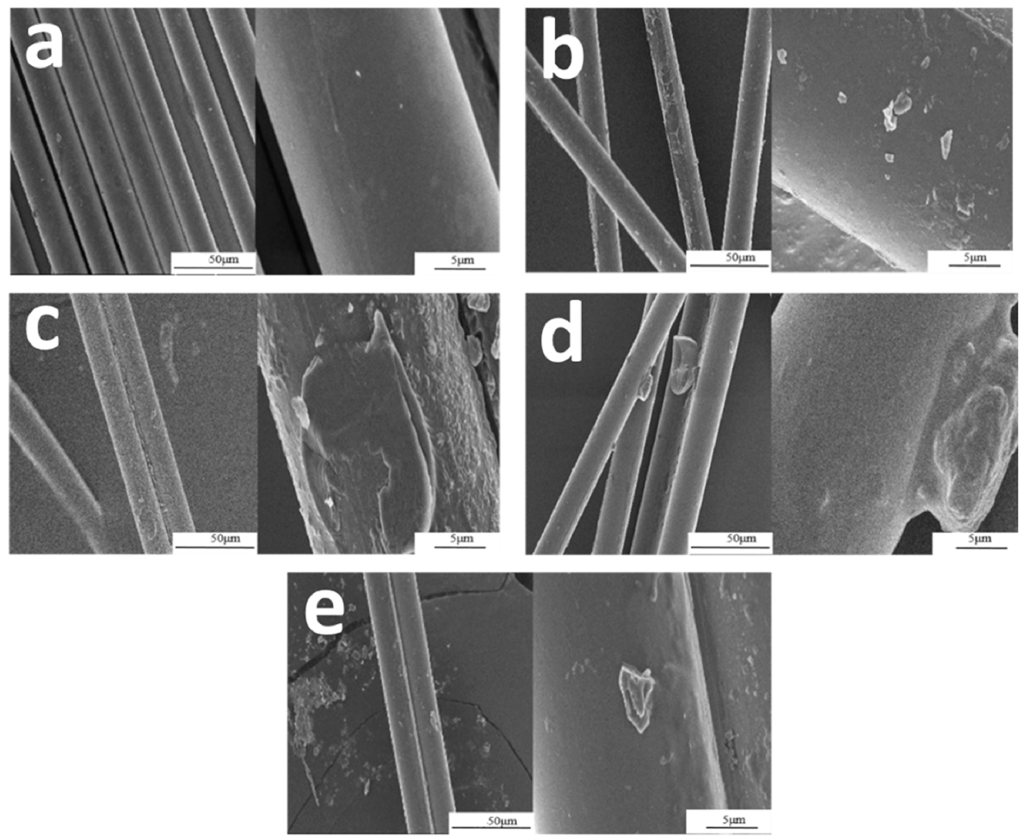
Figure 1. Scanning electron microscopy photographs of outer surface of the basalt fiber after pretreatment: ( a ) BF; ( b ) BF-MFT; ( c ) BF-SHT; ( d ) BF-AT; ( e ) BF-AAT.